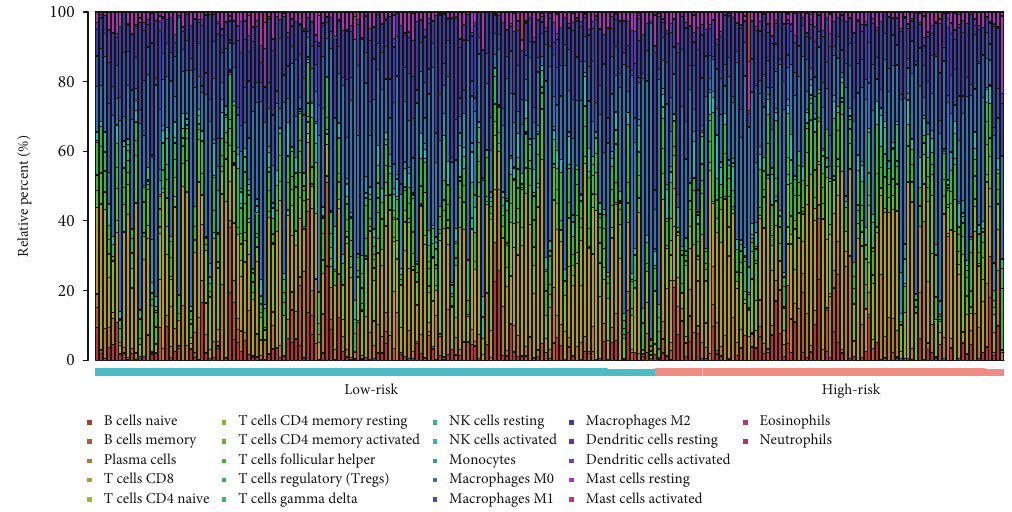
Figure 6: Estimation of fractions of immune cells using the CIBERSORT algorithm. The 22 immune cells were annotated by various colors, indicated below the